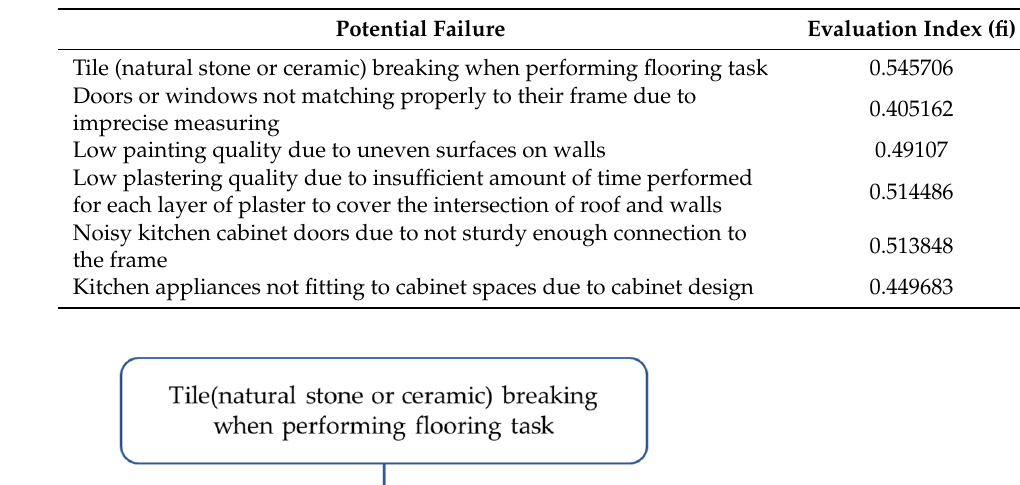
Table 6. Evaluation index for each potential failure.